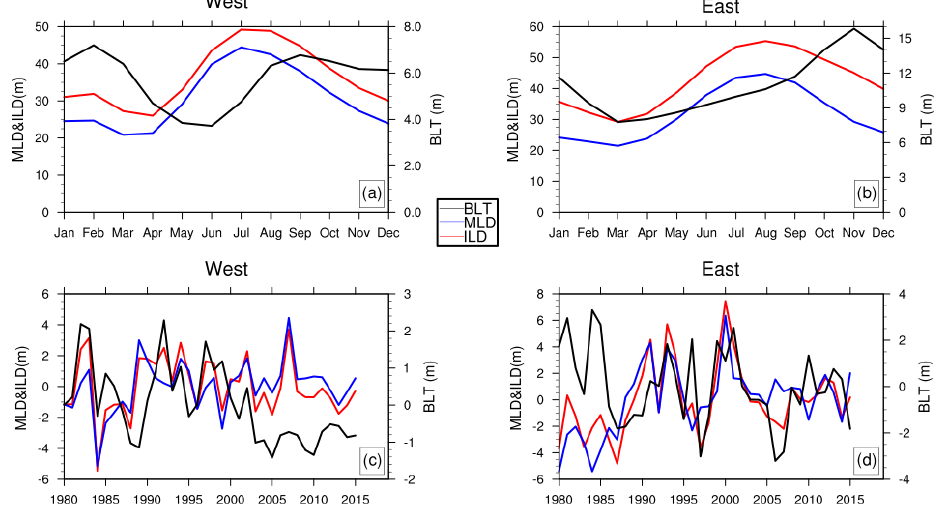
Figure 4. The seasonal and interannual variations of BLT, MLD, and ILD: (a, c) the western TIO (12 ◦ S–5 ◦ N, 55–75 ◦ E) and (b, d) the eastern TIO (12 ◦ S–5 ◦ N, 85–100 ◦